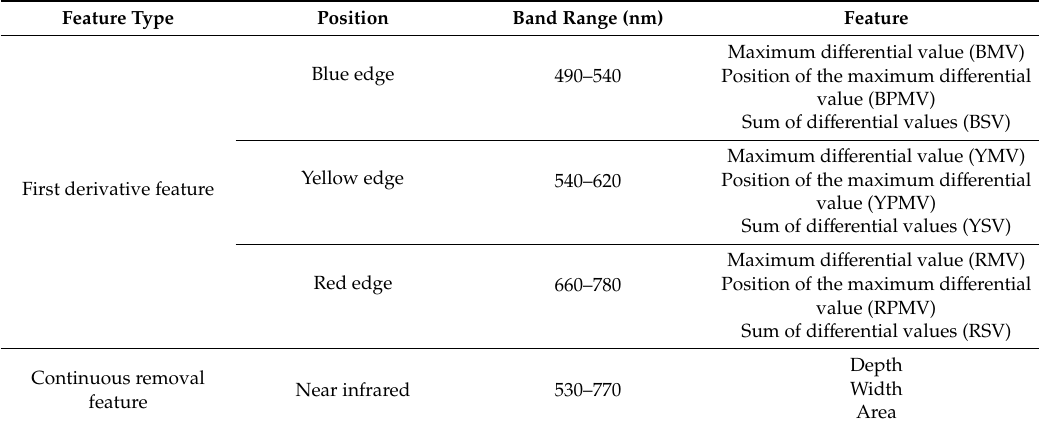
Table 3. Derivative and continuous removal spectral features used in this study.